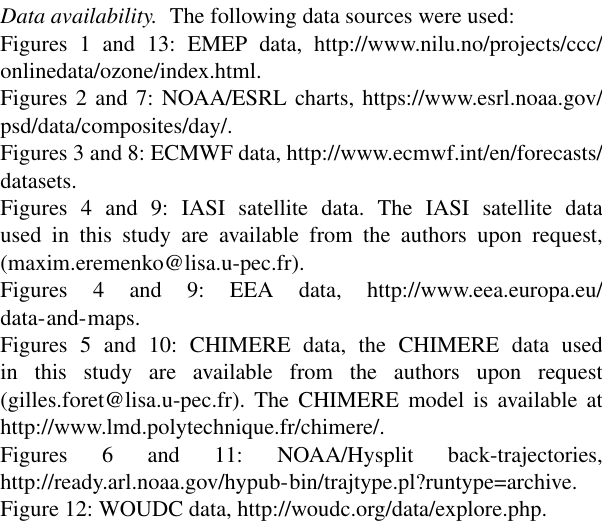
Figure 12: WOUDC data,